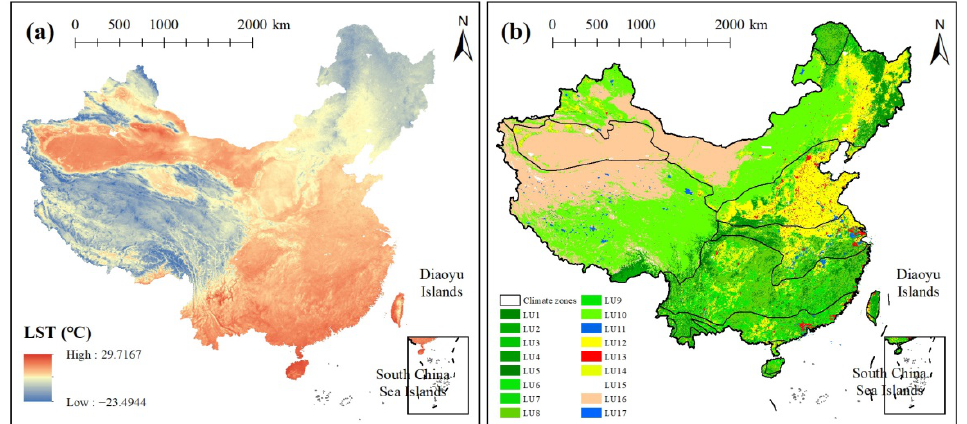
Figure A2. Distribution map of LST and LULC in 2010. LU1‒LU17 represent evergreen needleleaf